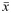
Escape latency of experimental subgroups in STM and LTM.Data are shown in x¯ ± SE. #differences between pristane and pristane+LPS groups, *differences between control and pristane or pristane+LPS. Unpaired Mann Whitney U test, P < 0.05. A) Escape latency in the STM phase at 7 weeks. B) Escape latency in the STM memory phase at 12 weeks. C) Escape latency in the LTM phase at 7 weeks. D) Escape latency in the LTM phase at 12 weeks.